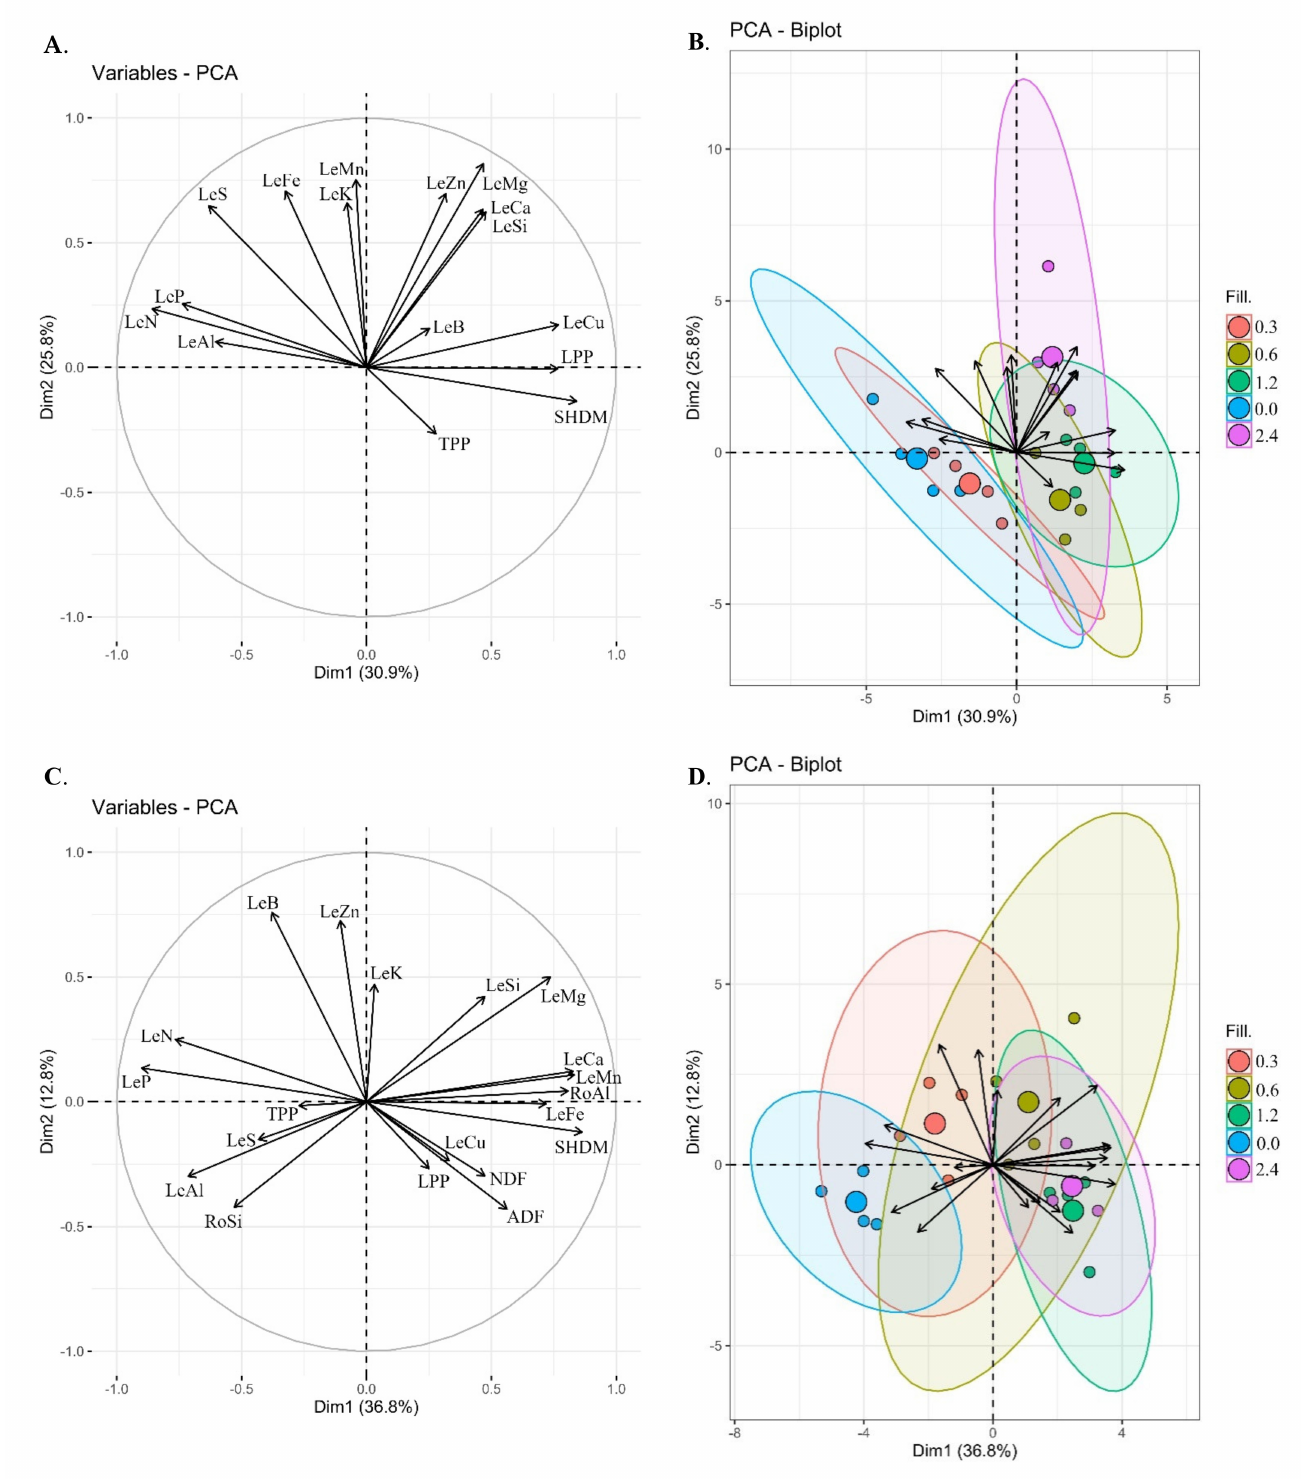
Figure 8. Loadings and biplot graphics of principal component analysis among the relationship between Xara é s palisade- grass shoot dry mass (SHDM), leaves per plot (LPP), tillers per plot (TPP), neutral detergent fiber (NDF), acid detergent fiber (ADF), leaf Al, Si, N, P, K, Ca, Mg, S, B, Cu, Fe, Mn, and Zn concentrations (LeAl, LeSi, LeN, LeP, LeK, LeCa, LeMg, LeS, LeB, LeCu, LeFe, LeMn, and LeZn), root Al and Si concentration (RoAl and RoSi) evaluated in the first ( A , B ) and second cuts ( C , D